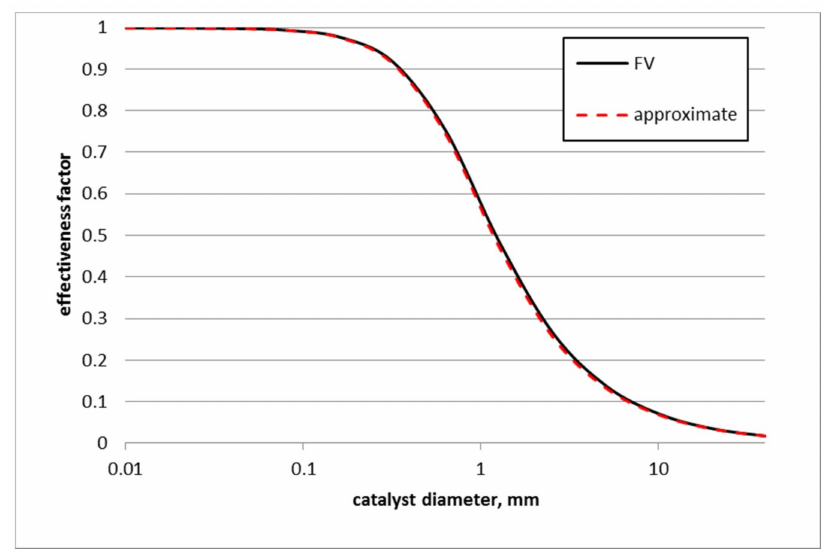
Figure 7. Effectiveness factors for toluene hydrogenation case as functions of particle